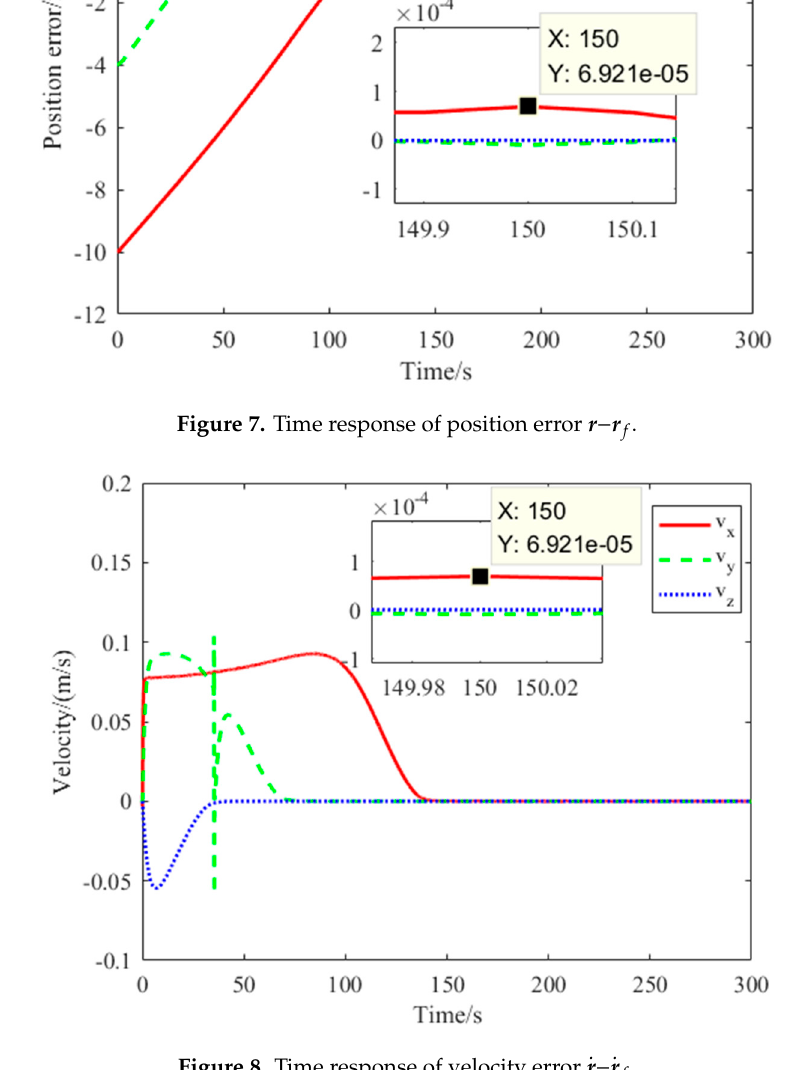
Figure 8. Time response of velocity error